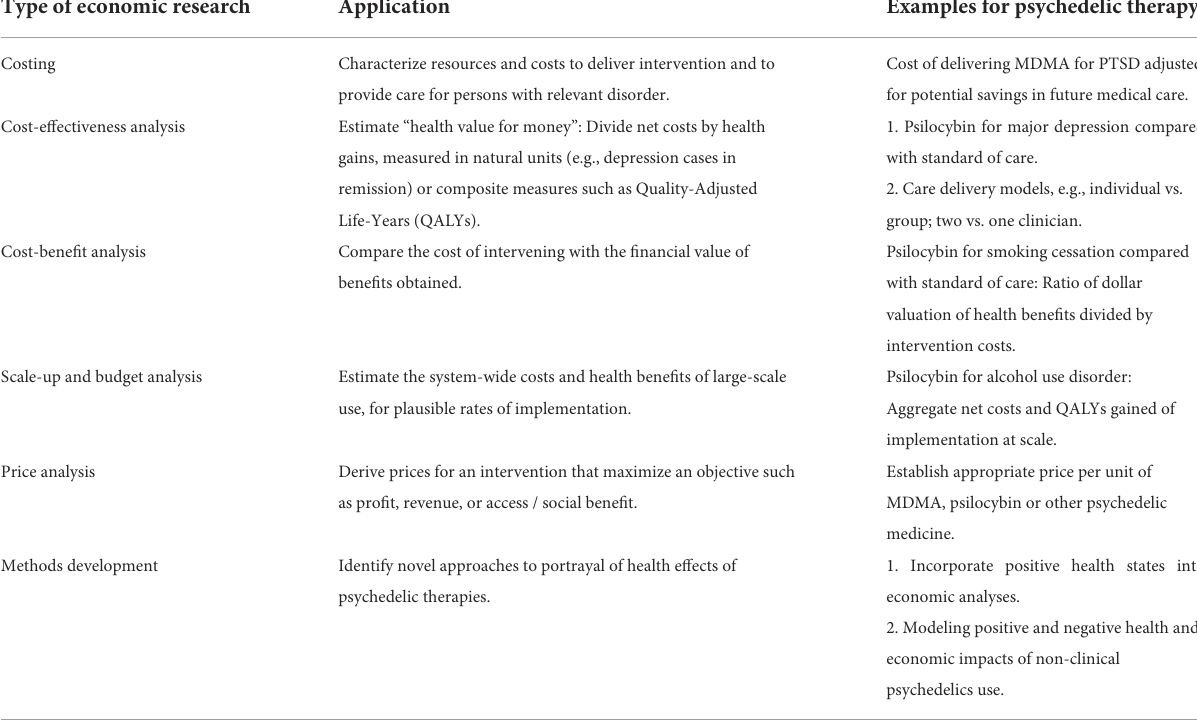
TABLE 1 Six types of health economic research and their application to the assessment of psychedelic